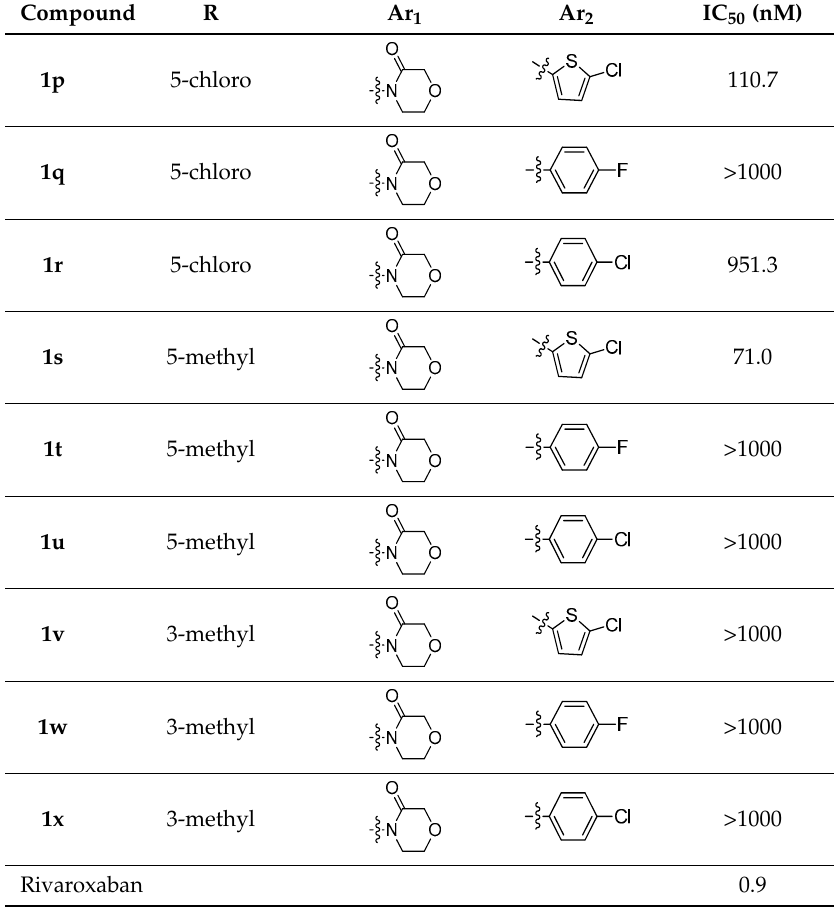
Table 1. The structures of the target compounds 1a – 1x and their biological activity evaluation.